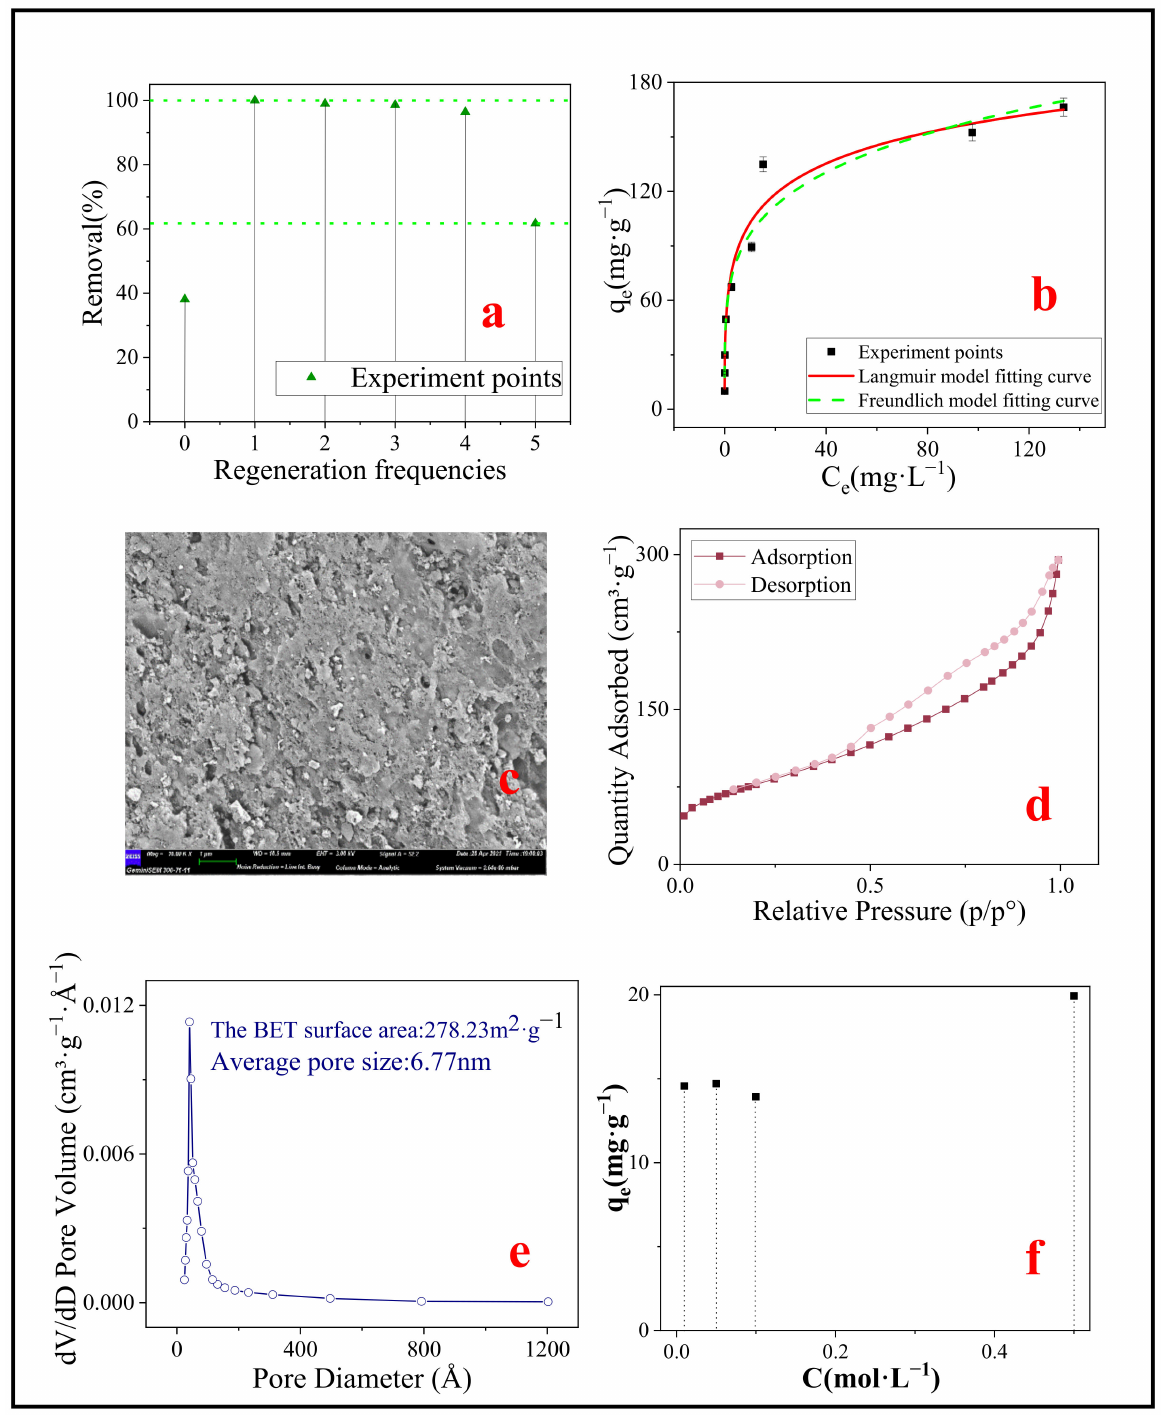
Figure 9. ( a ) Regeneration of SMB; ( b ) Isotherm models of SMB after one regeneration (298 K); ( c ) SEM image of SMB after one regeneration; ( d ) N 2 adsorption–desorption isotherm liner plots of SMB after one regeneration; ( e ) BJH pore size distribution of SMB after one regeneration; ( f ) Adsorption capacity of SMB after one regeneration of hydrochloric acid at different